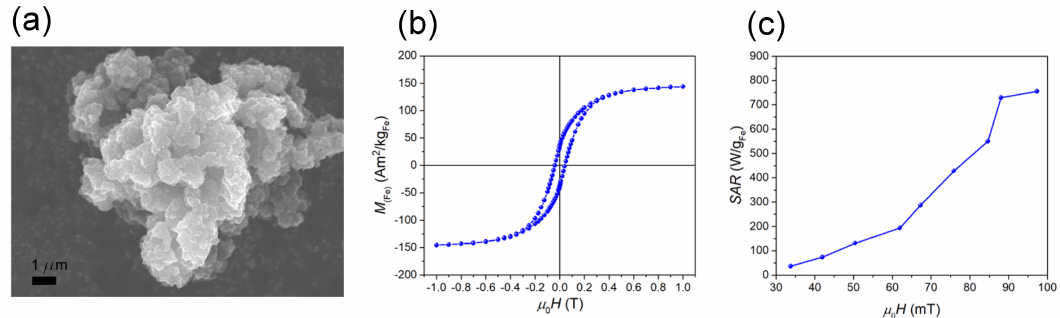
Figure 1. ( a ) SEM image of the room-temperature magnetization curve. ( b ) Specific absorption rate (SAR) (measured at 273 kHz) as a function of the AC-field amplitude ( c ) of the magnetic nanoparticle-containing support